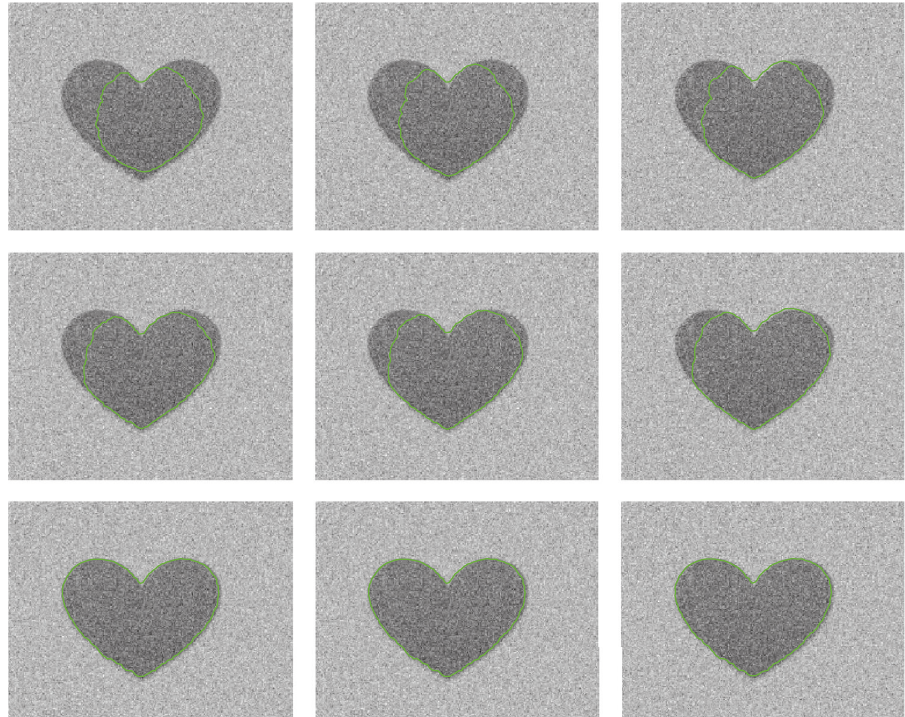
Figure 2: Contour evolves within few block